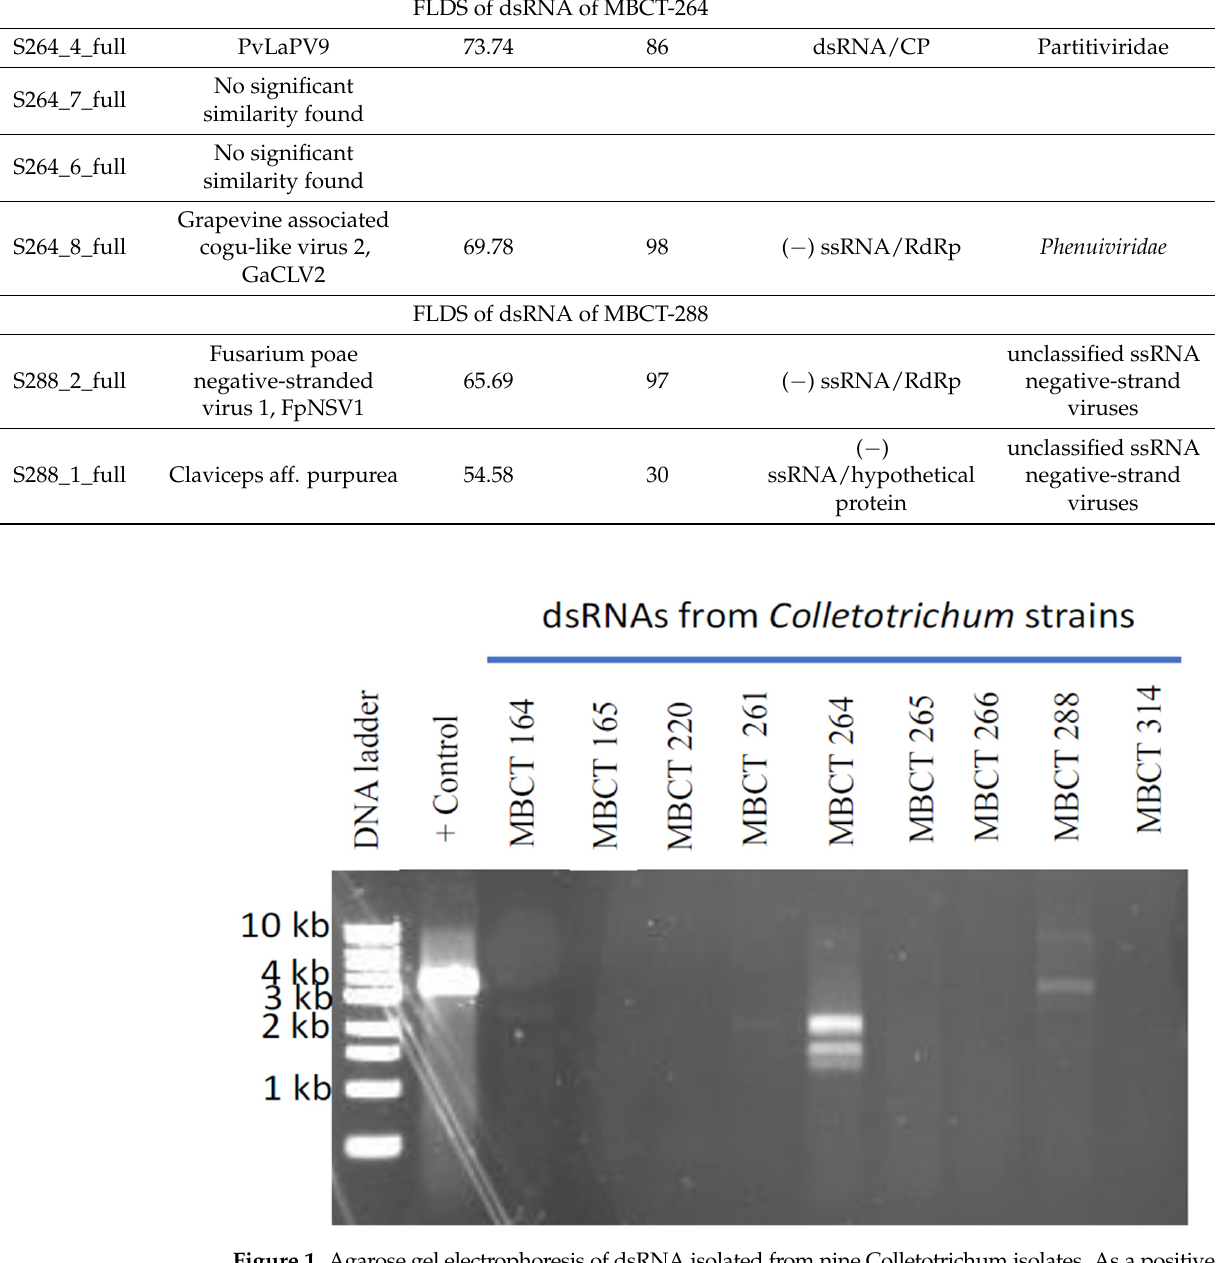
Figure 1. Agarose gel electrophoresis of dsRNA isolated from nine Colletotrichum isolates. As a positive control, we used dsRNA from Magnaporthe oryzae chryso-virus 1 (MoCV1) A infected Magnaporthe oryzae isolate. Clear and distinct dsRNA bands were found in two Collectotrichum isolates, MBCT-264 and MBCT-288. Table 2. Assembled sequences with best similarity in BLASTx to those of previously described vi- ruses.